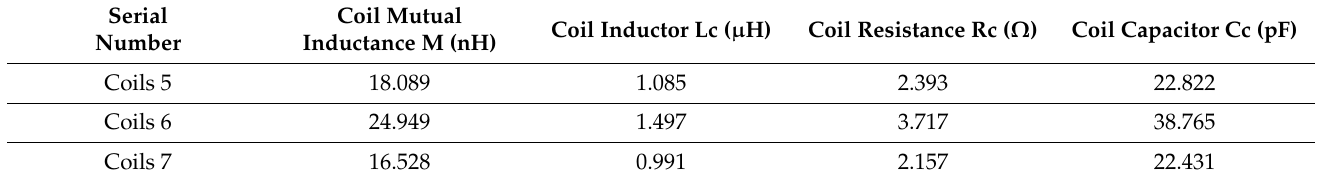
Table 5. Electrical parameters of coil 5–7.